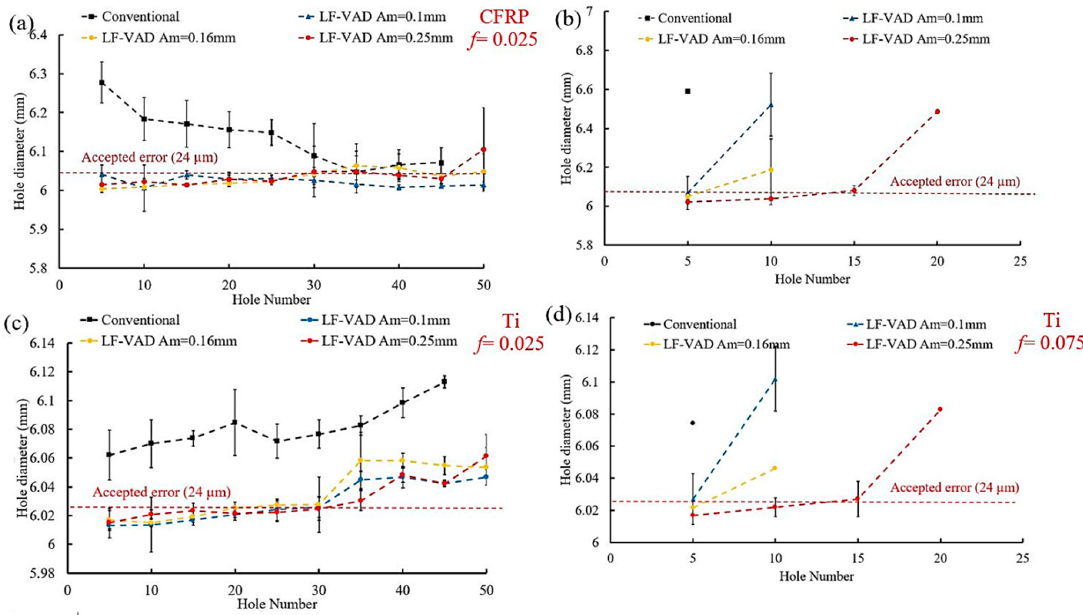
Figure 22. The e ff ect of machining technique and wear progress on the hole accuracy at N = 56.52 m / min Figure 22. The effect of machining technique and wear progress on the hole accuracy at N = 56.52 and di ff erent feeds for ( a , b ) CFRP and ( c , d ) m/min and different feeds for ( a , b ) CFRP and ( c , d ) Ti6Al4V.